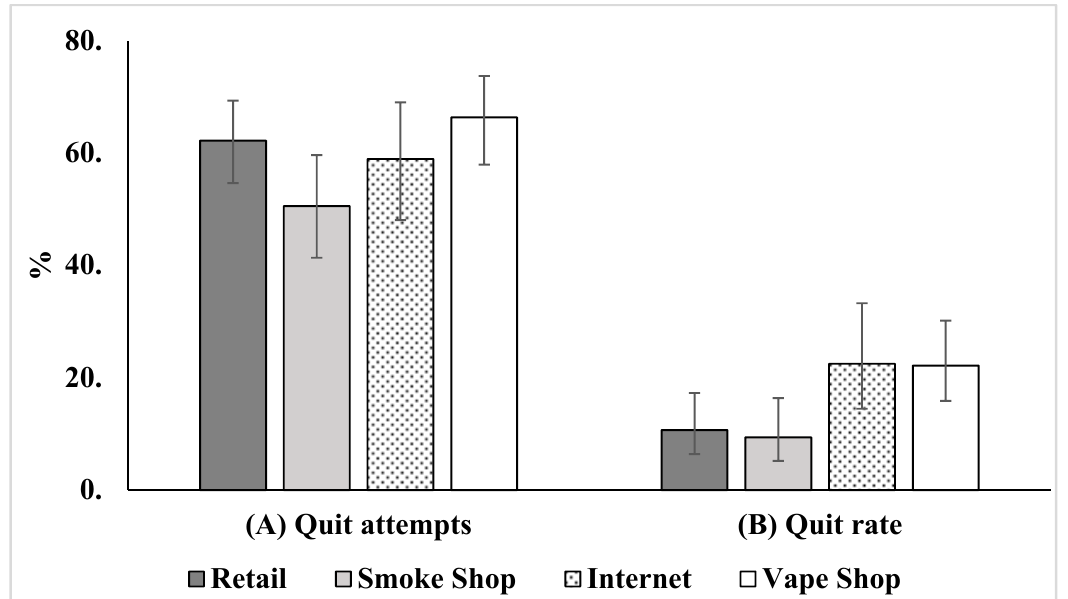
Figure 1. Quit attempt and cessation rate by place of purchase, among those who were smokers 12 months before the survey. ( A ) Quit attempts; ( B ) quit rate.